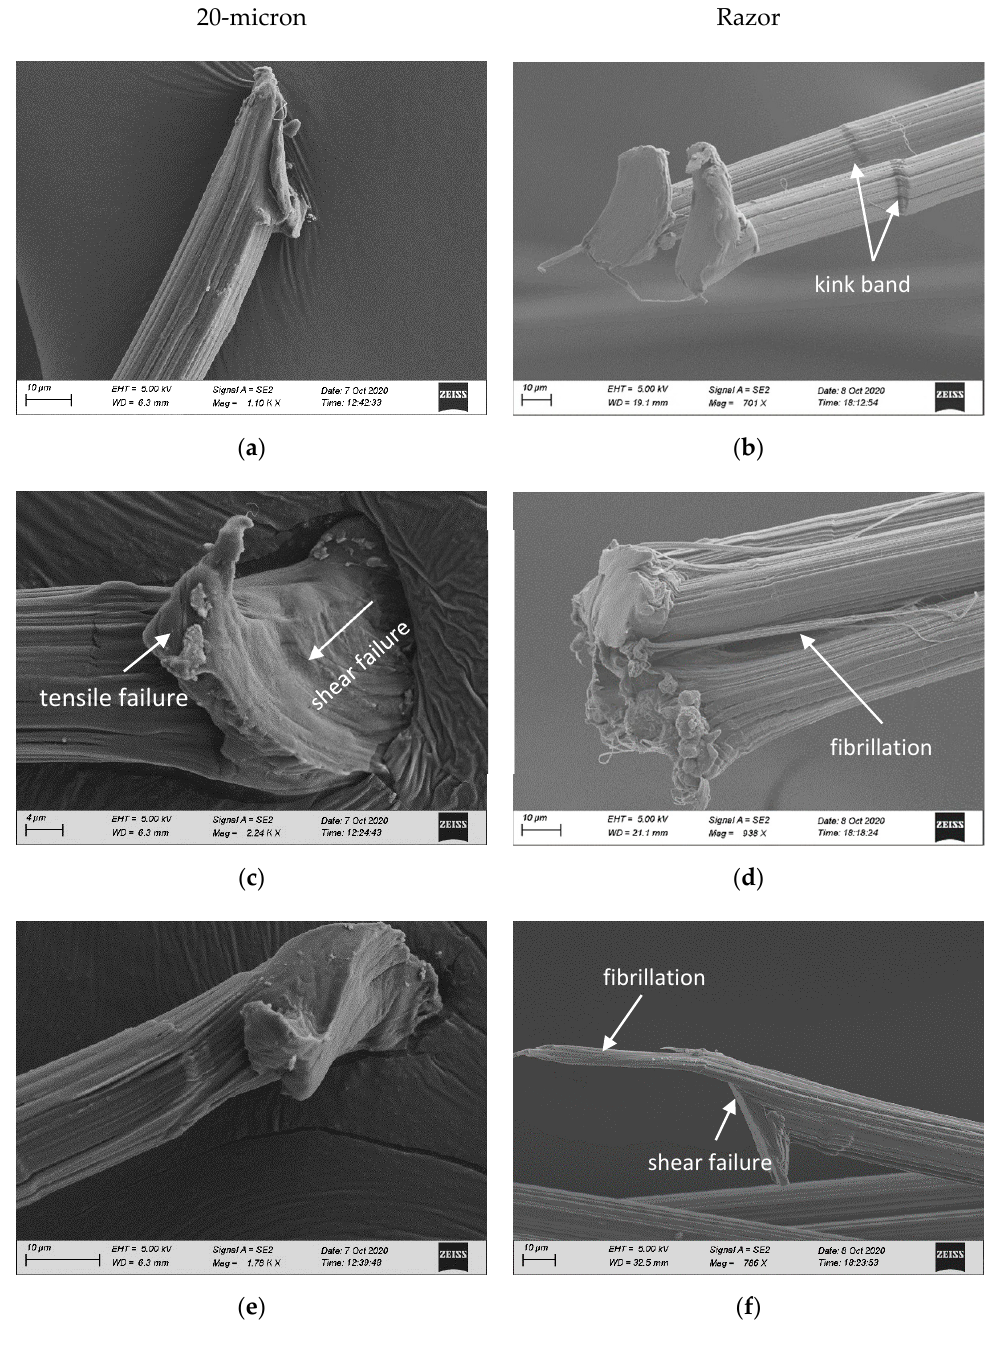
Figure 6. SEM image of the fiber fracture surface ( a , c , e ), for the 20-micron indenter and ( b , d , f ) for the razor blade.